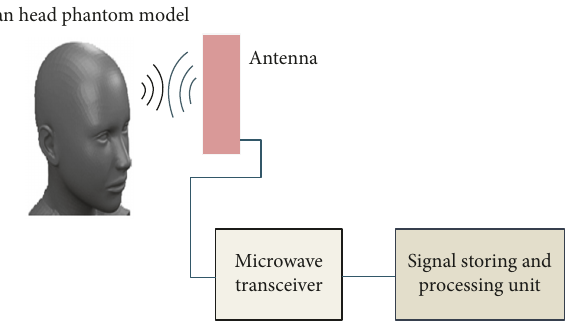
Figure 1: Schematic diagram of monostatic radar-based microwave brain imaging system